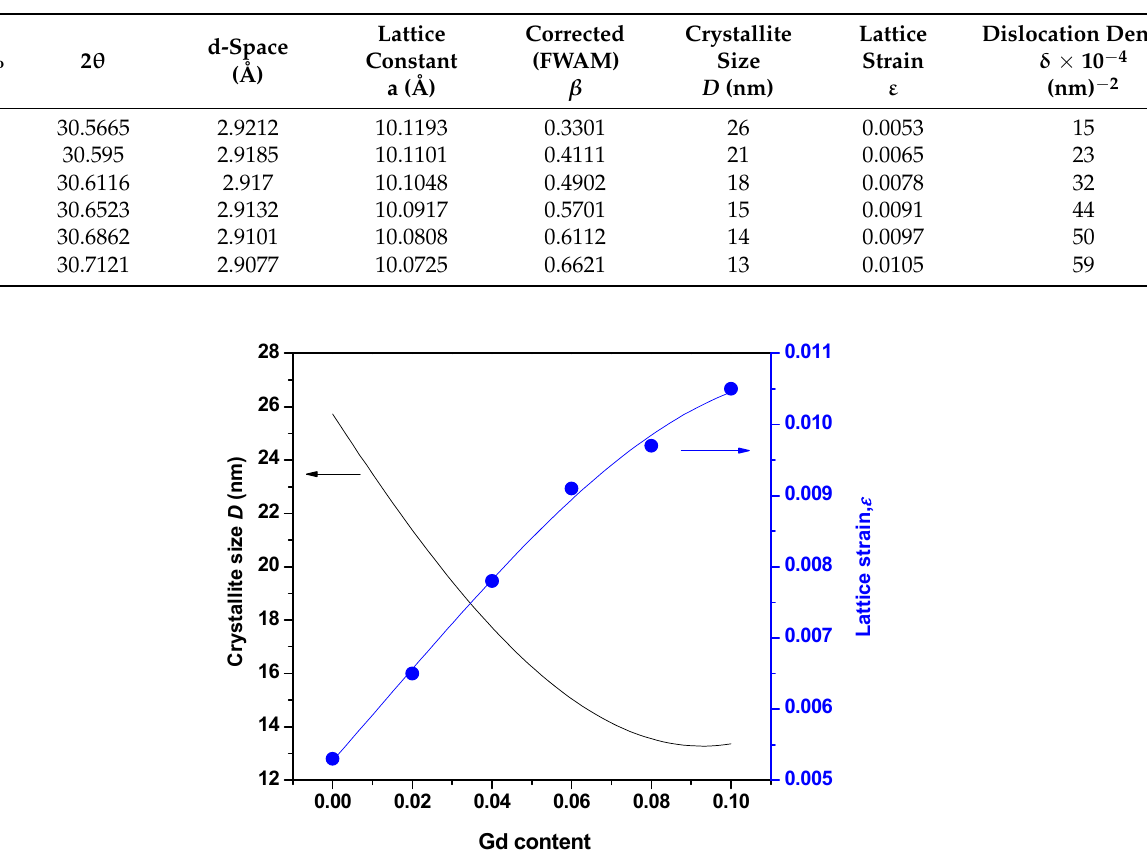
Table 1. Structural parameters for (In 1 − x Gd x ) 2 O 3 thin films.